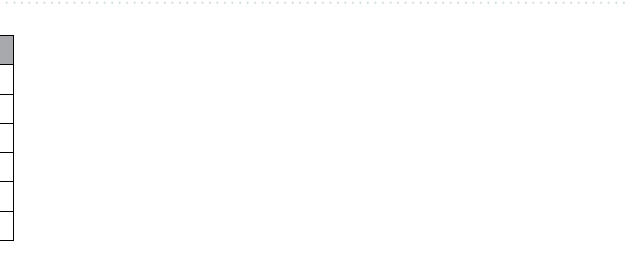
Table 1. Memory operating condition of n - and p